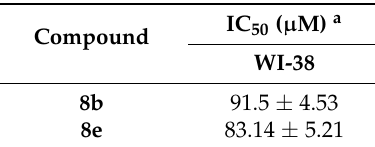
Table 3. Cytotoxic activity of compounds 8b and 8e against non-tumorigenic human lung fibroblast WI-38 cell line.